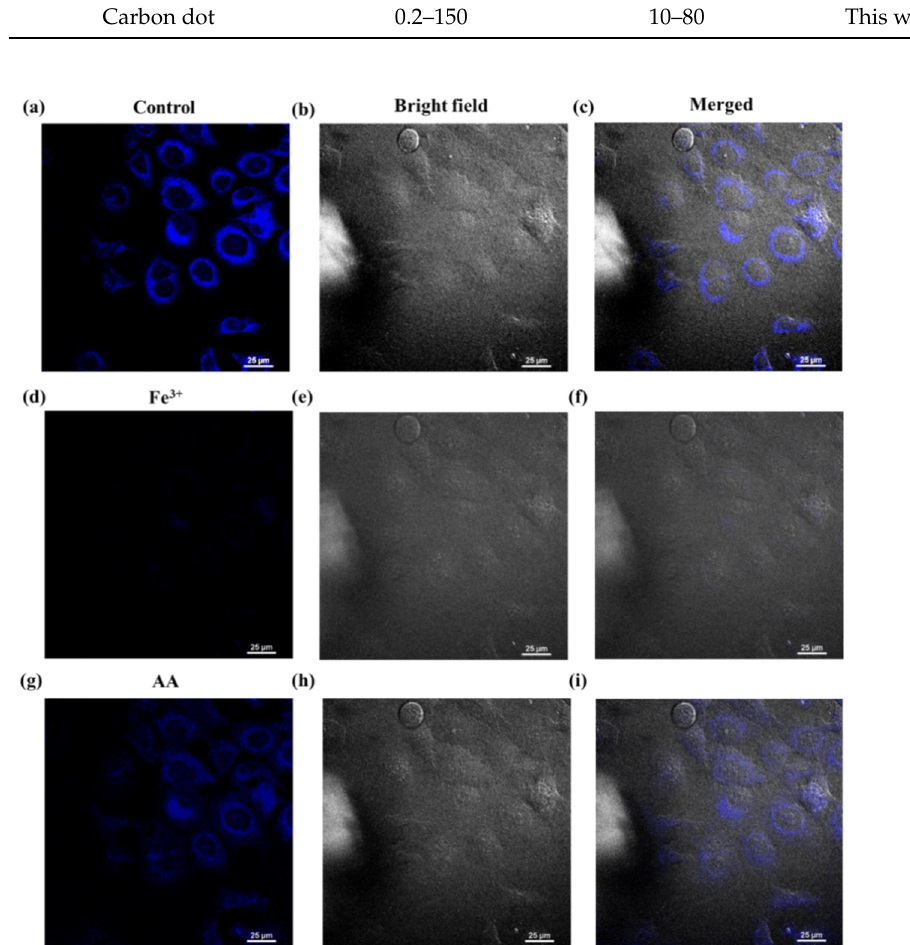
Figure 7. Blue fluorescence field, bright field, and merged cell imaging of NFCDs ( a – c ) without Fe 3+ and AA, ( d – f ) after adding 100 μL Fe 3+ (concentration: 10 mM), and ( g – i ) after 100 μL Fe 3+ (concentration: 10 mM) and adding 200 μL AA (concentration: 10 mM).